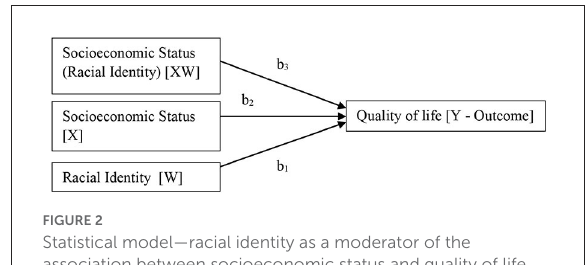
TABLE 2 Quality of life score multiple comparisons by racial identity: Scheffé post-hoc criterion.